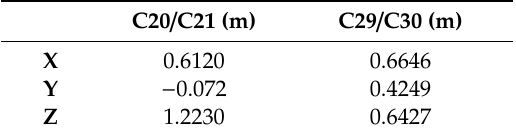
Table 2. The Centre-of-Mass Correction of LRAs for BDS-3 satellites.